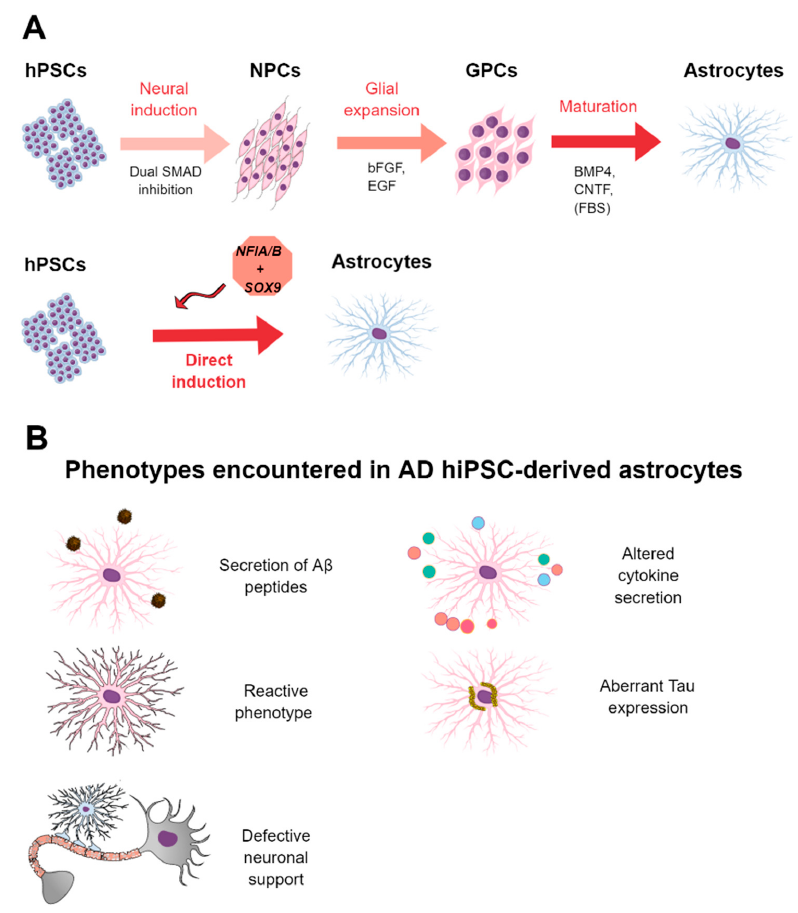
Figure 2. ( A ) The two most used approaches for the derivation of hPSC-derived astrocytes are represented: dual SMAD inhibition-based protocols and expansion of glial precursor cells